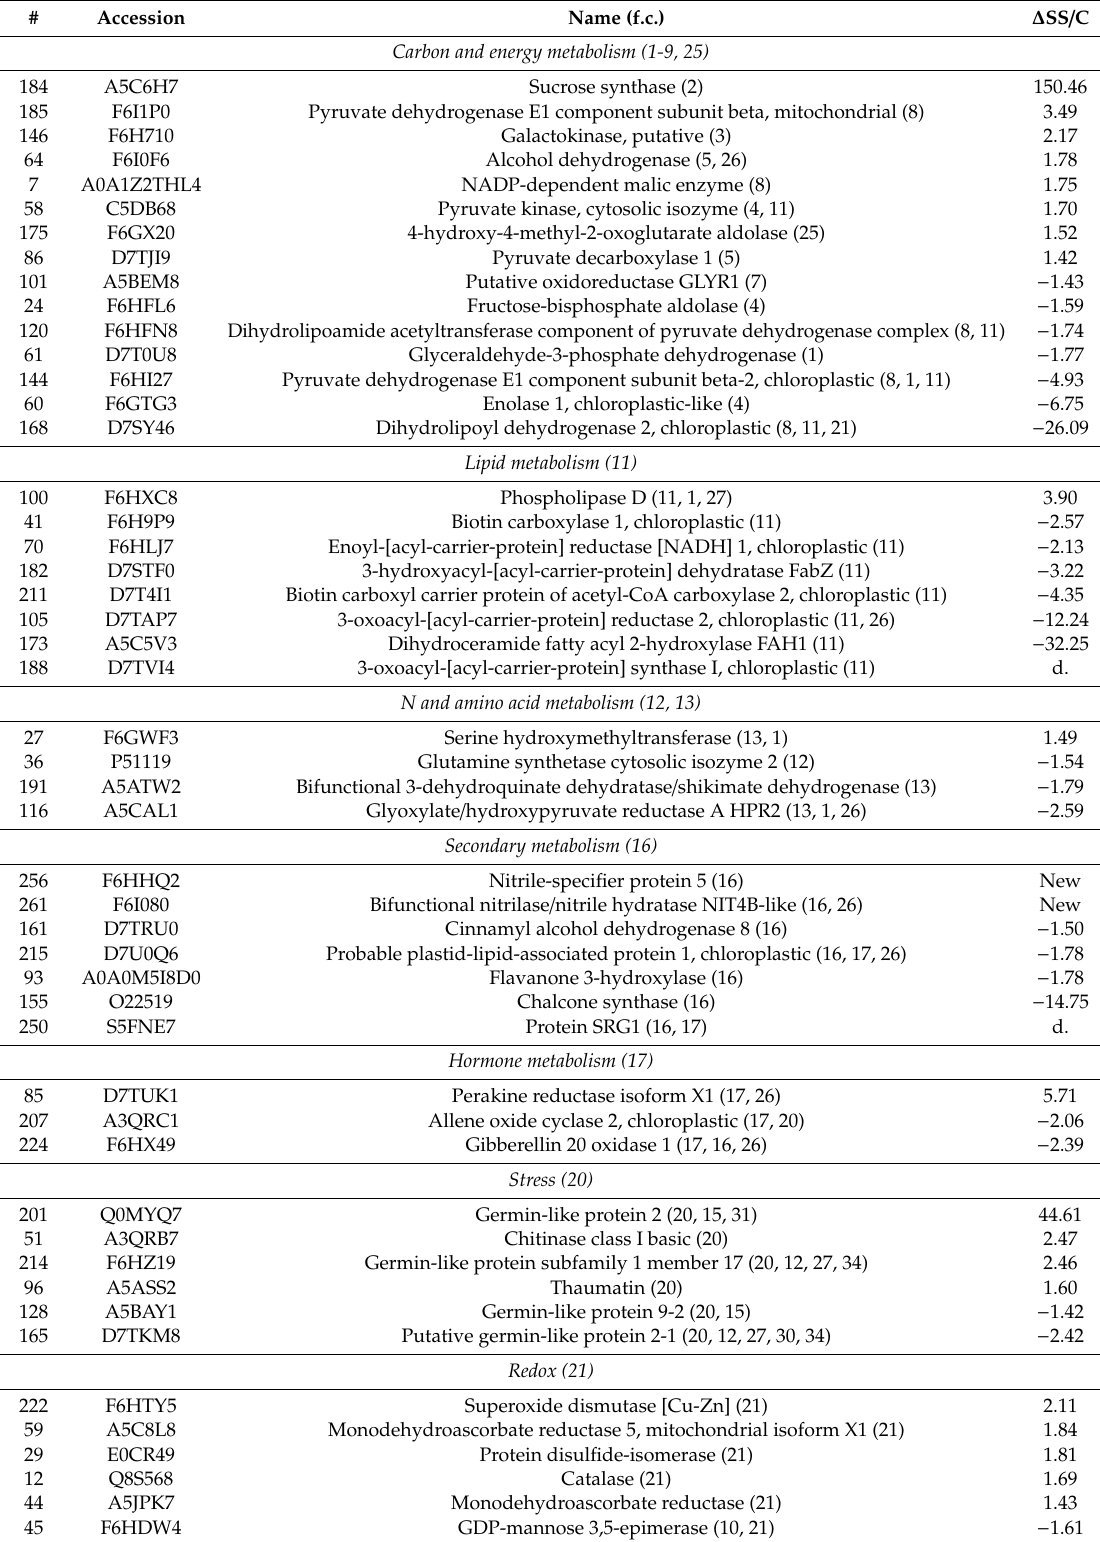
Table 2. Proteins showing significant changes in responses to salt stress in the 101.14